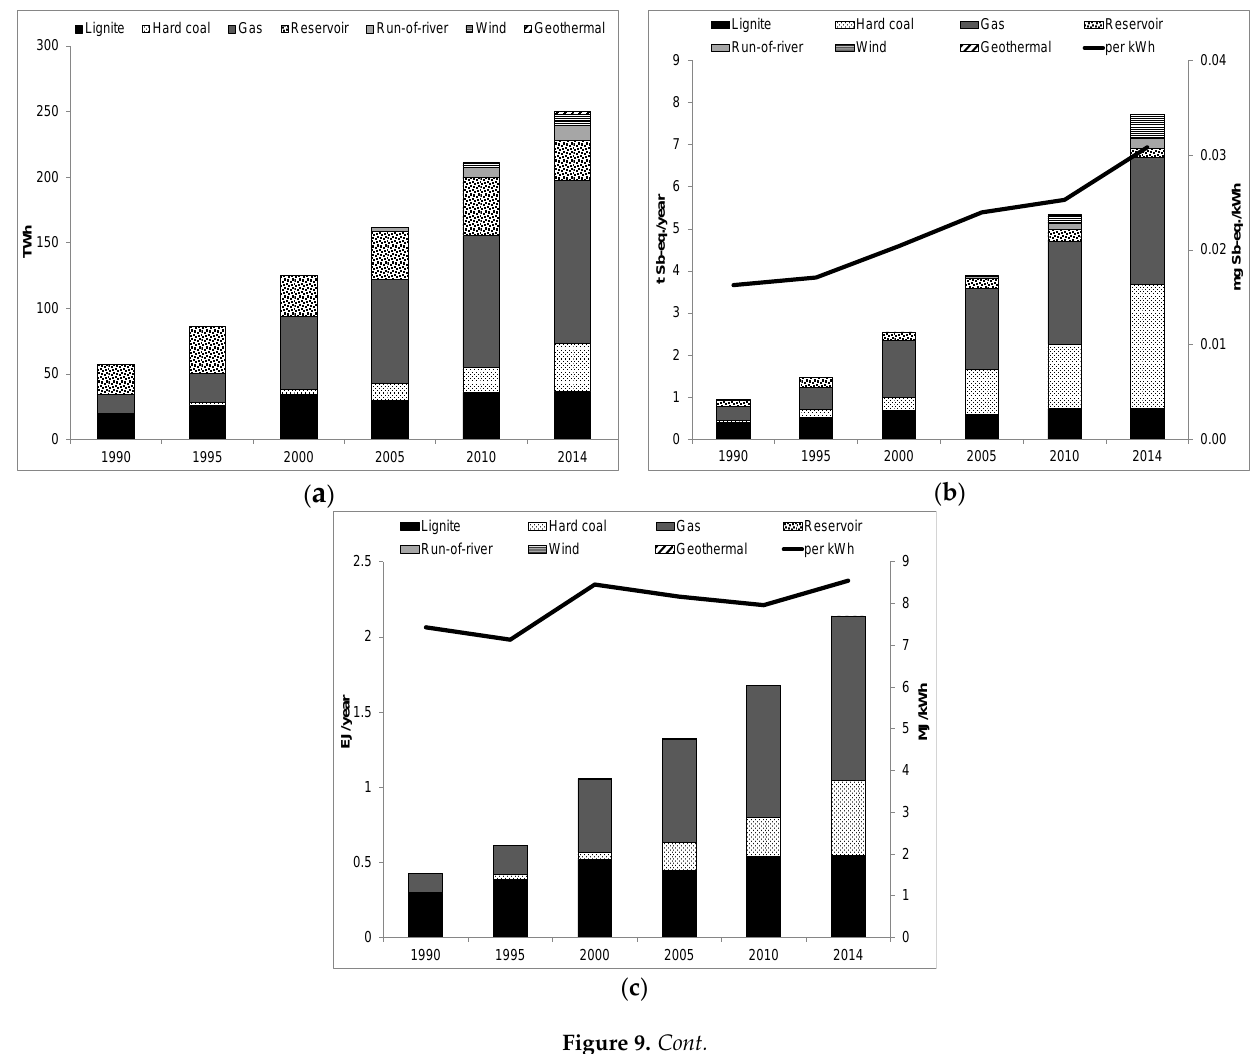
Figure 9. Cont. Figure 9.